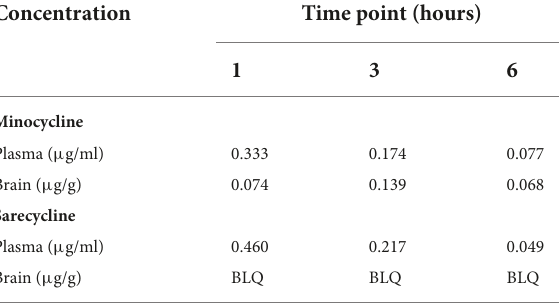
TABLE 1 Concentration of minocycline and sarecycline in plasma ( µ g/ml) and brain ( µ g/g) after intravenous administration.